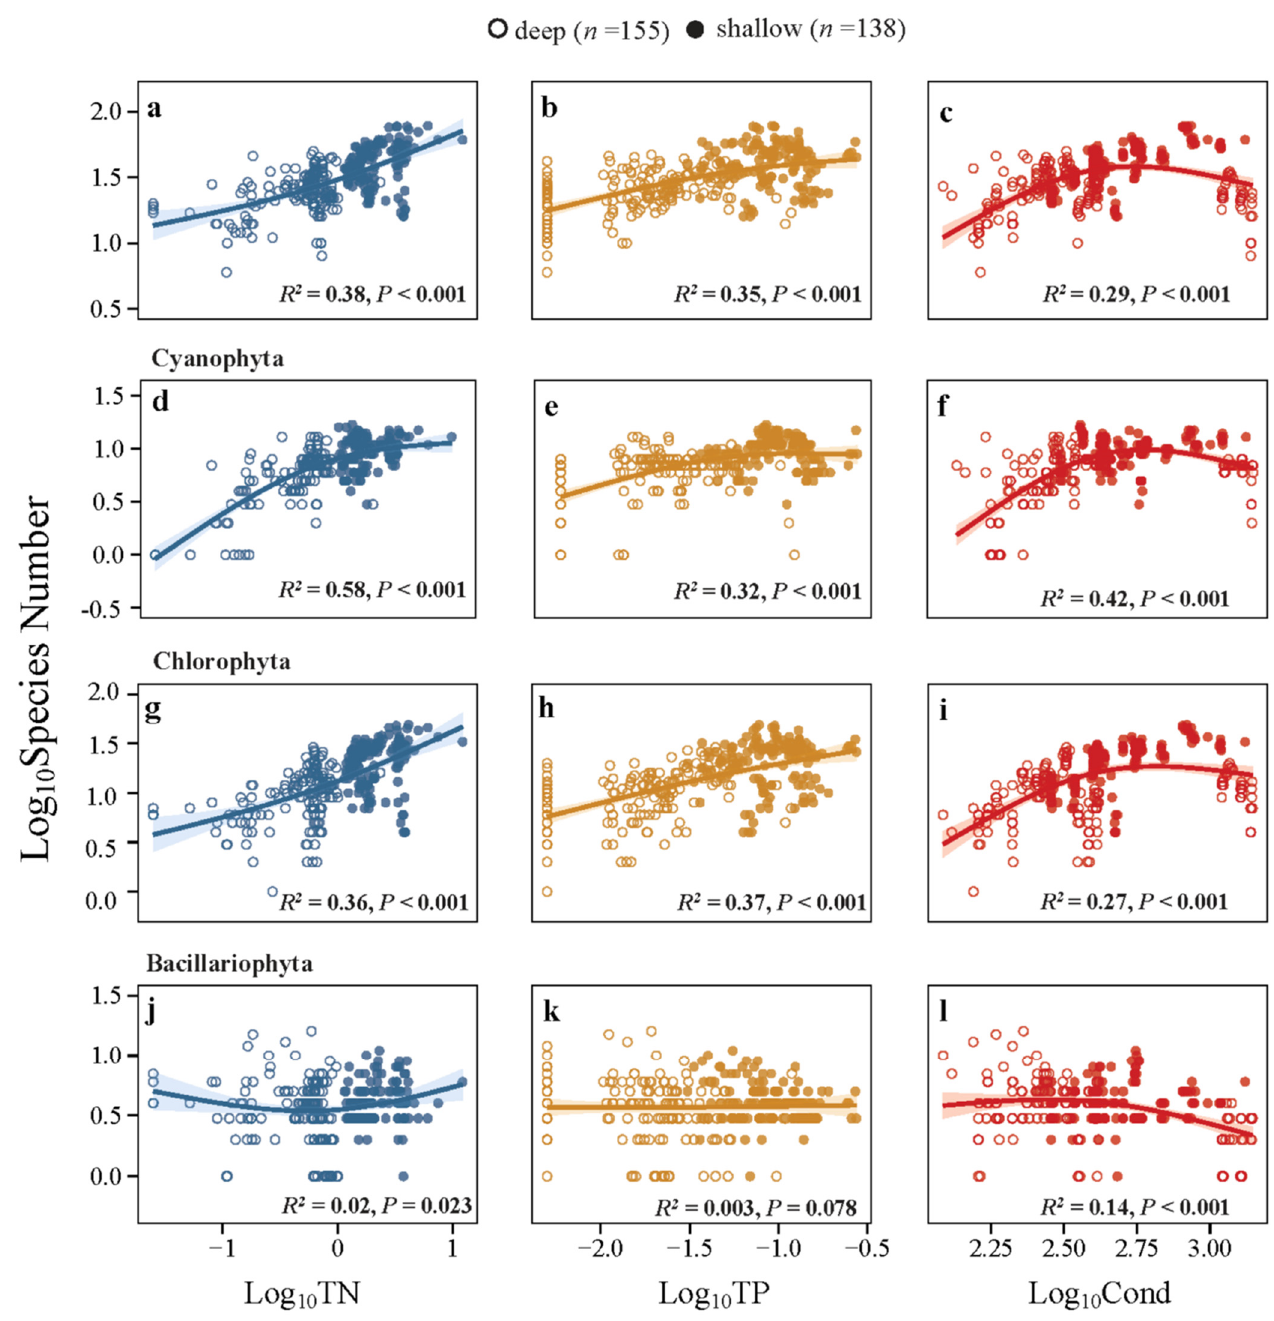
Figure 2. Generalized additive model showing the relationships between TN, TP, and Cond and species number of total phytoplankton ( a – c ), cyanophyta ( d – f ), chlorophyta ( g – i ), and bacillariophyta ( j – l ) in the studied lakes. The studied lakes are divided into two groups according to mean depth (Z): DC, XYH, YLH, and QLH = shallow lakes with Z < 10 m, LGH, CH, YZH, and EH = deep lakes with Z > 10 m. For model parameters see Table S1.